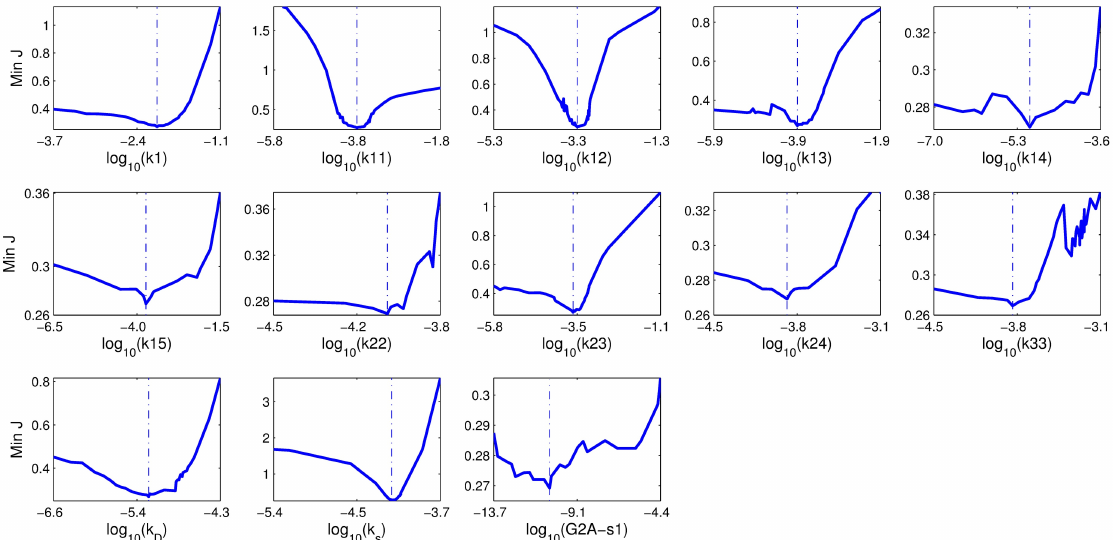
Fig 6. Blue lines display the profile likelihood for the parameter. The vertical dashedlines indicate the optimal values of the parametersshown in Table 4. Each parameter was varied over a wide range aroundits optimalvalue, and the remaining parameterswere then refitted. All parameter values were